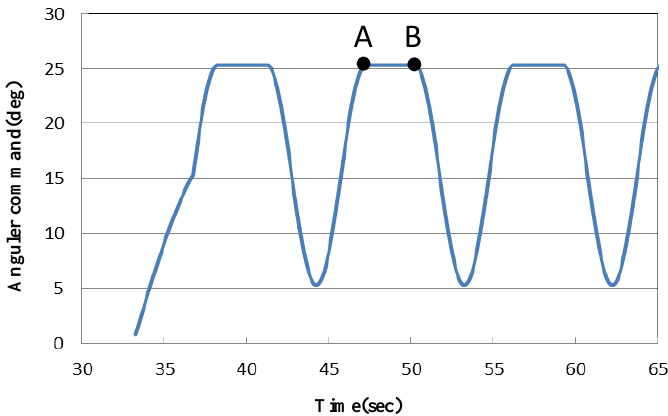
Figure 6. Angular command for the front motor. Figure 4. Angular command for the front motor